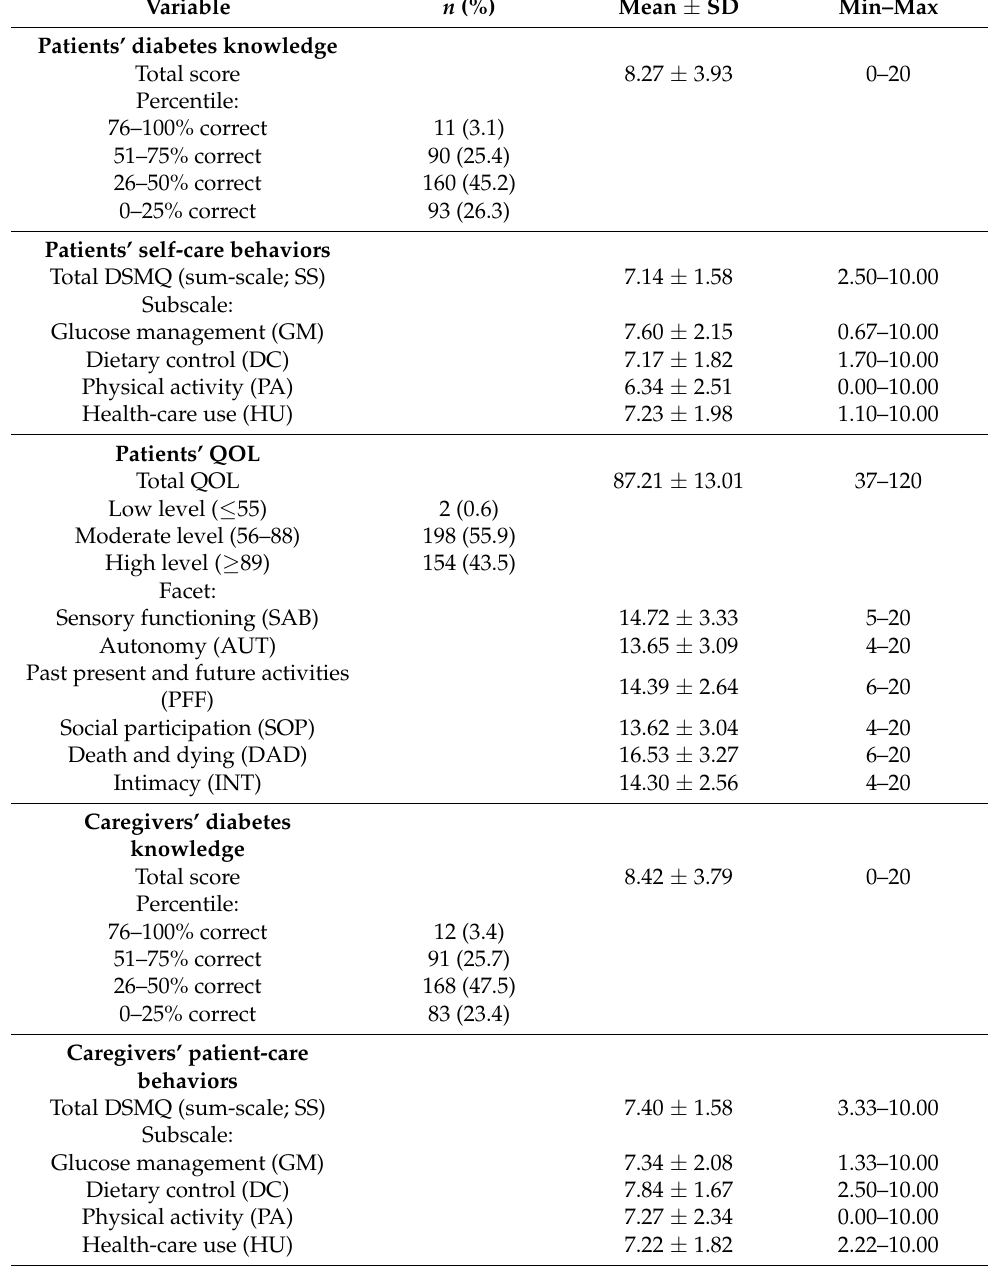
Table 3. Diabetes knowledge and behavior for both groups, and patients’